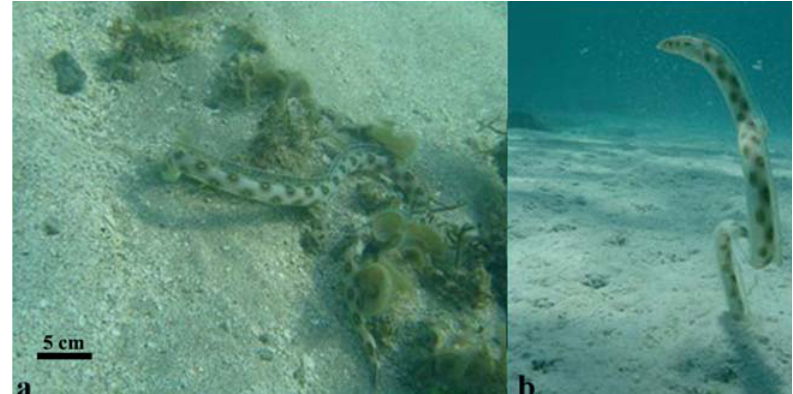
Fig. 2. Myrichthys ocellatus during feeding behavior: (a) beginning search behavior; (b) burying its head and opening the hole wider with its tail. Photos by S. Marques (a) and V. Marques (b).